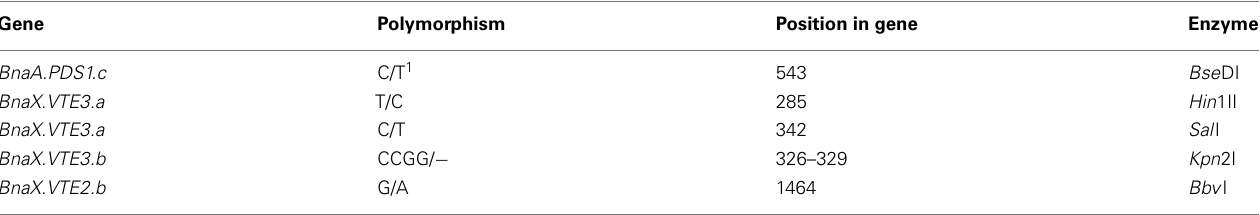
TableA3 | Polymorphisms within tocopherol candidate genes and enzymes, which were used as allele-specific markers for genotyping the 133